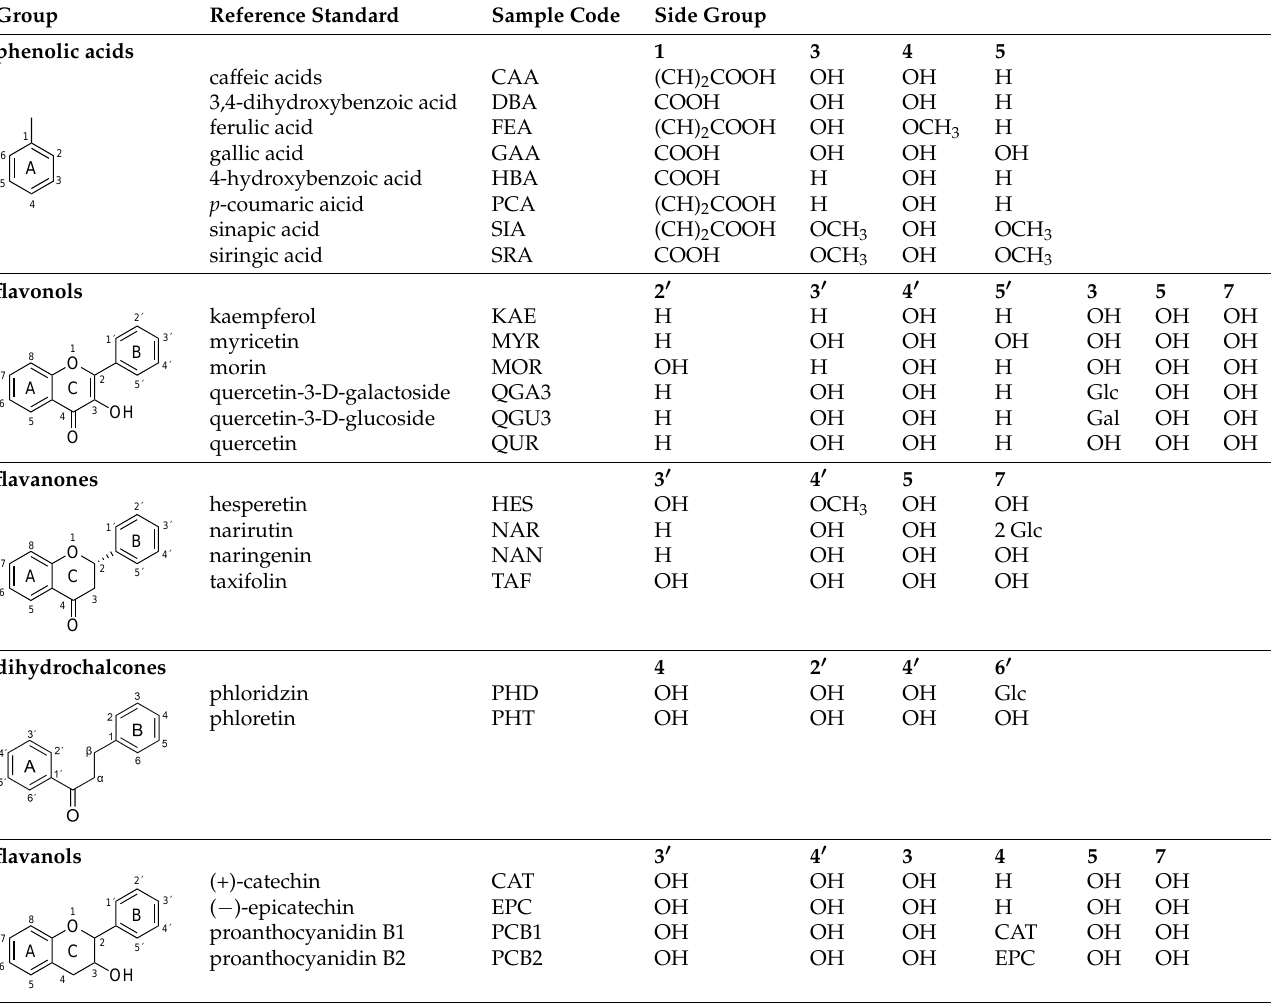
Table 1. Summary of the phenolic compounds, reference standards, sample codes and corresponding side groups.